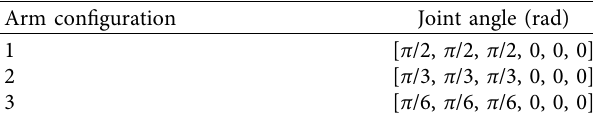
Table 2: Different configurations of the